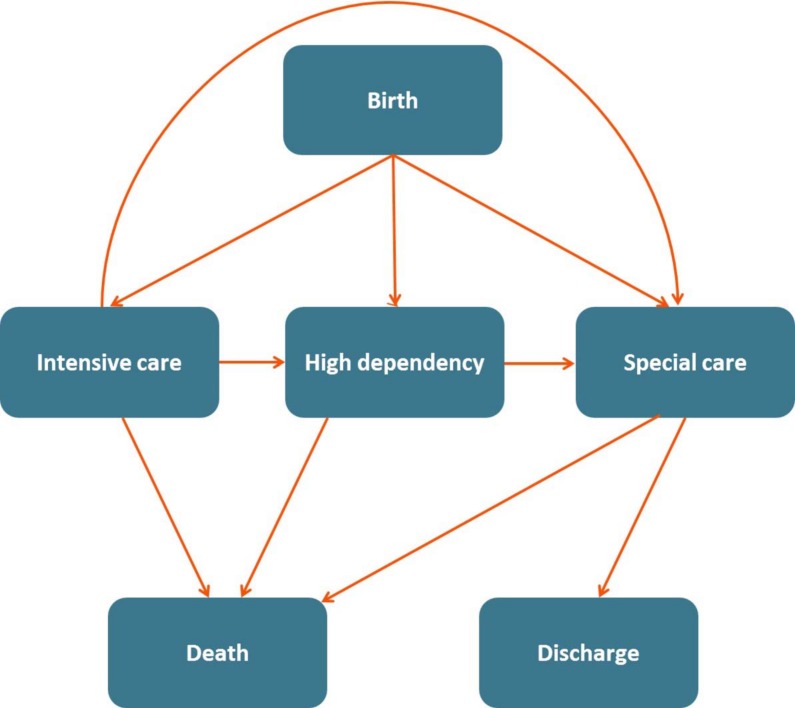
The multistate model used here to describe the neonatal care pathway.All babies begin in the birth state before following transitions (arrows) throughout the model until reaching death or discharge.